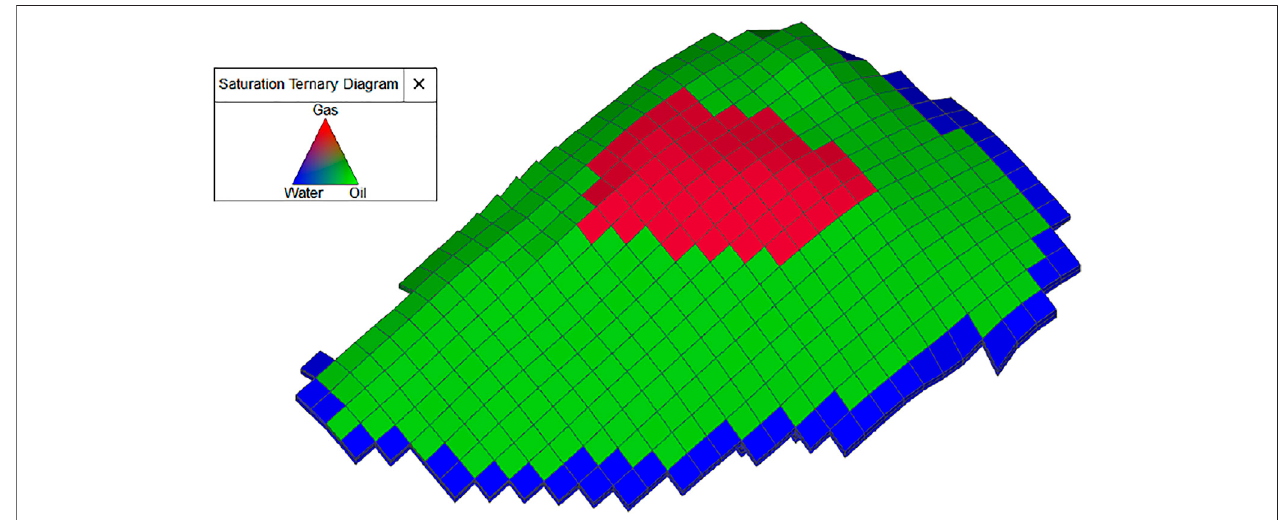
FIGURE 5 | Saturation ternary diagram of the PUNQ-S3 case.